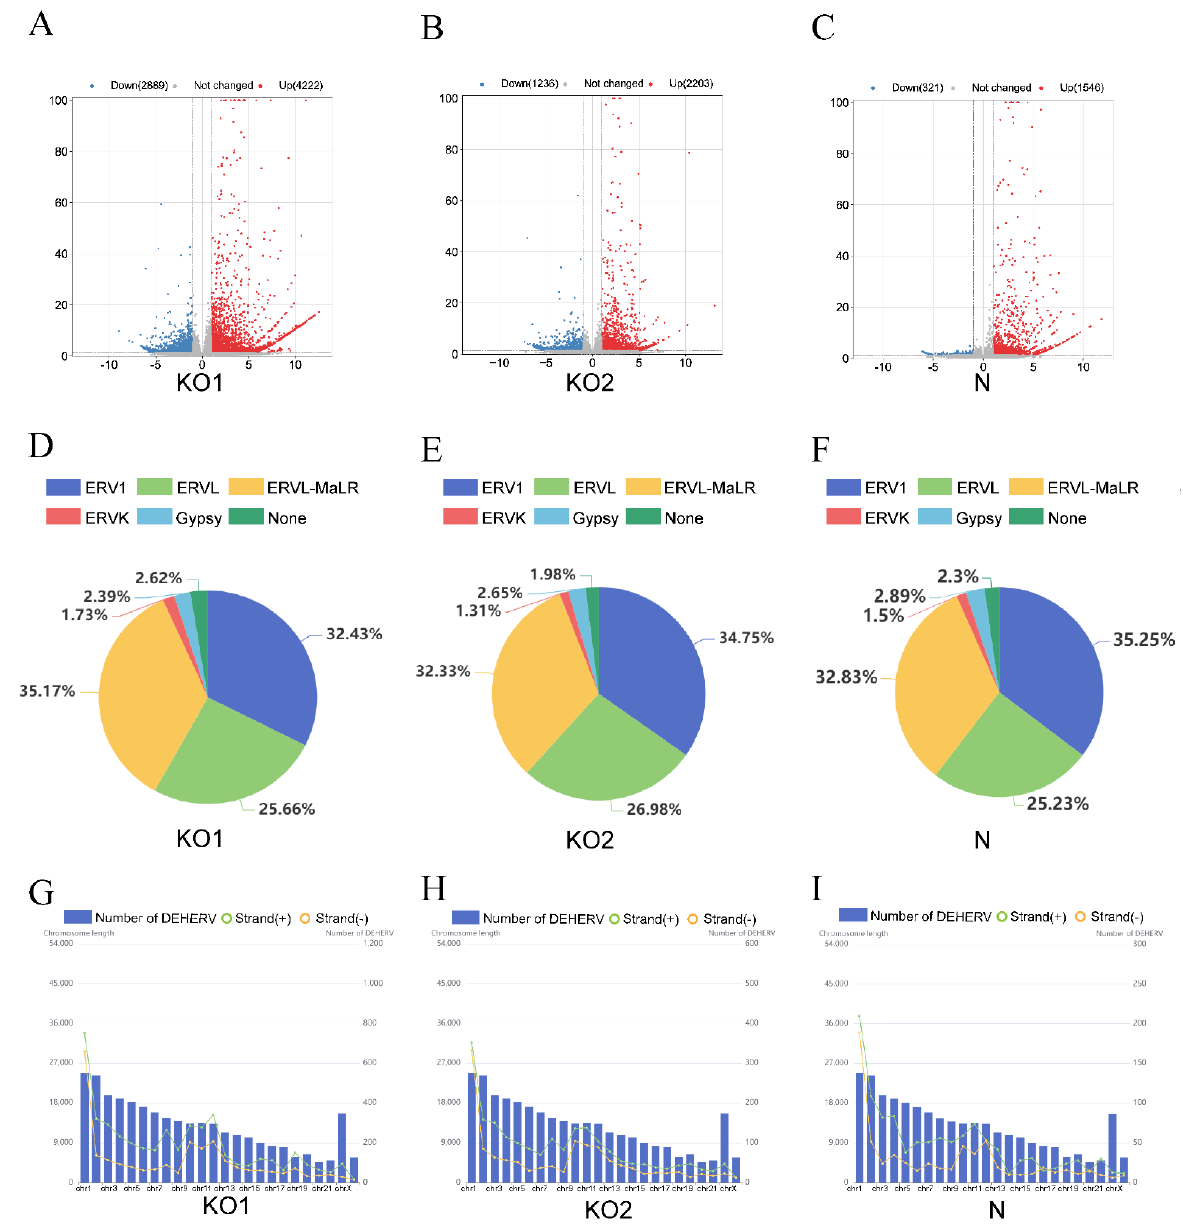
Figure 2. Screening and classification of DEHERVs. ( A – C ) Volcano plots of the three groups (KO1, KO2, and N). Red and blue-colored dots represent upregulated and downregulated HERV loci, respectively (adjusted P-value < 0.05 and |log2 fold change| > 1). Gray-colored dots represent loci with no significant differential expression. ( D – F ) Pie charts showing the number of DEHERVs in each superfamily of three groups. ( G – I ) Distribution of DEHERV loci on the plus (green point) and minus (orange point) strands of each chromosome. The blue bar represents the length of each human chromosome.